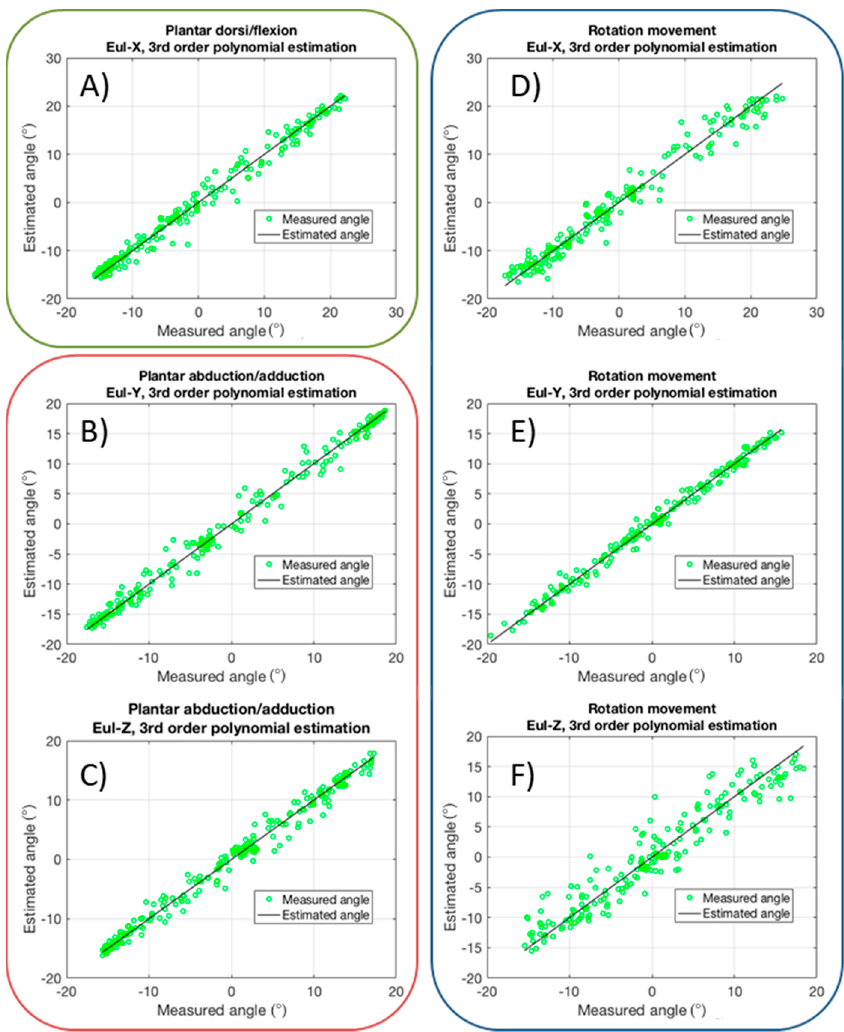
Figure 13. Output characteristics for main angles in different movements using third order polynomial fitting estimation: Eul-X ( A ) for dorsi/plantar flexion; Eul-Y ( B ) and Eul-Z ( C ) for abduction/adduction; Eul-X ( D ), Eul-Y ( E ), Eul-Z ( F ) for rotation.